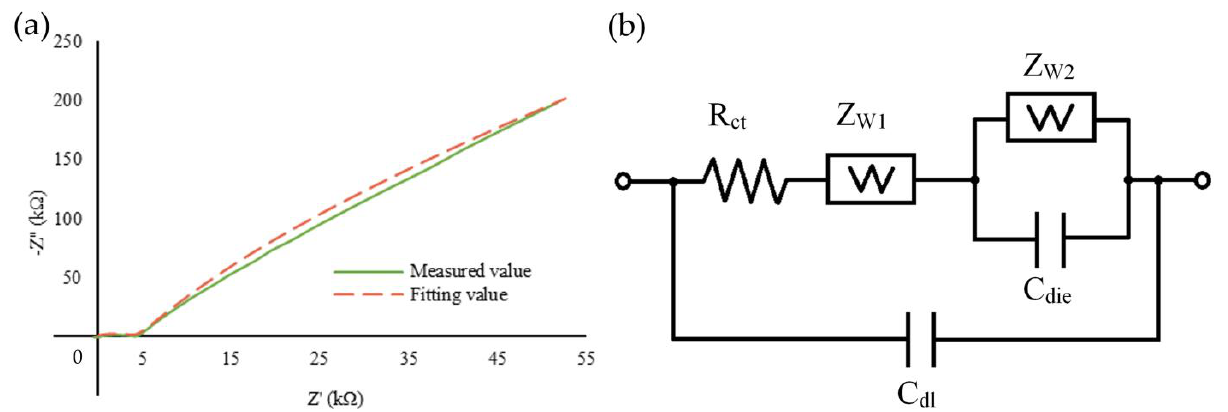
Figure 10. The “Cole– Cole p lot” of the impedance and the fitted curve at 10⁶ cfu/mL of E. coli ( a ); equivalent Randle’s circuit represent ing the electrochemical system of the IDμE sensor ( b ). Table 2. Simulated data of the component in the equivalent circuit for the E. coli sample at different concentrations.